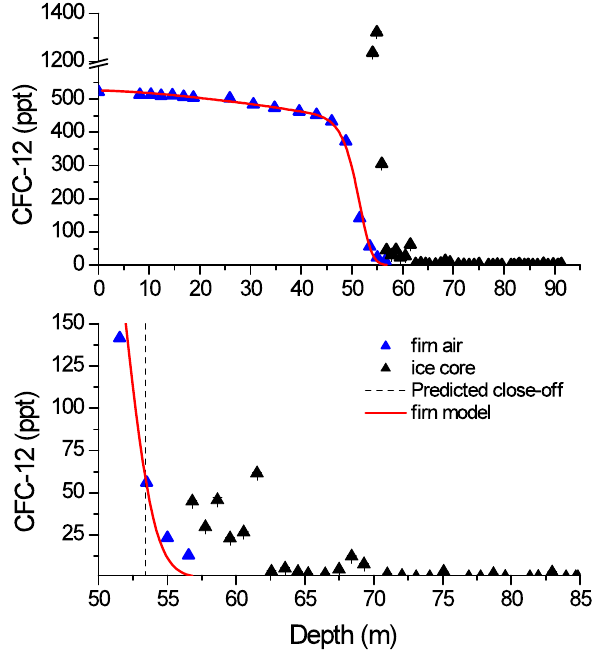
Fig. 2. Both panels – NOAA firn air data from the 1996 campaign (blue triangles) at Siple Dome, and UCI ice core data (black triangles) for Siple Dome C ice core drilled in 1995. The red line is the CFC-12 profile generated by the firn model. In the lower panel, the scales of x- and y-axes are adjusted to focus in on the firn-ice transition. The dashed line represents the full firn close-off depth as estimated by equation (1).